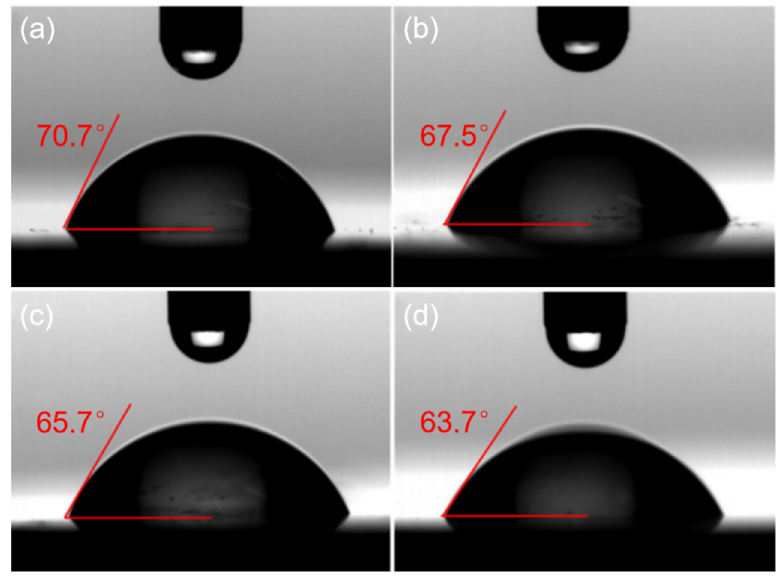
Figure 3. Air-water contact angles on CALB-loaded ZIF-8 substrates: ( a ) ZCP-10; ( b ) ZCP-20; ( c ) ZCP-40; and ( d )ZCP-80.